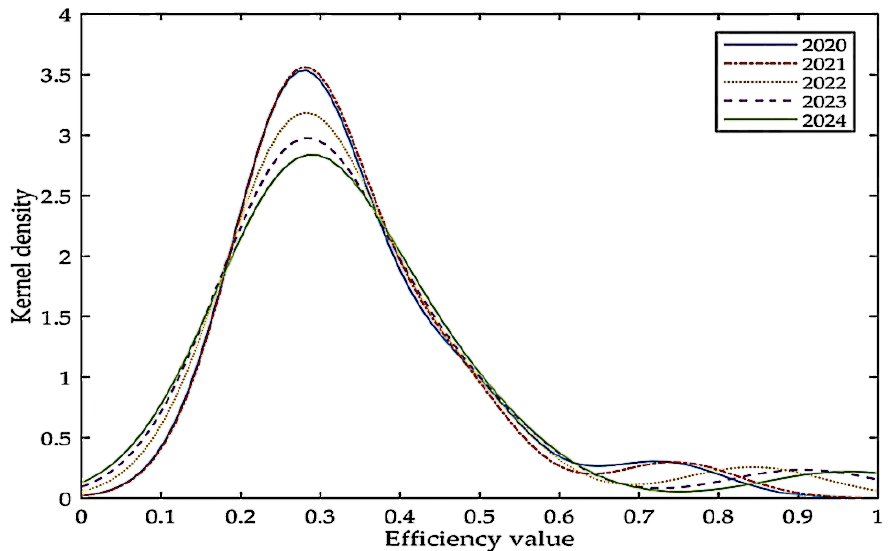
Figure 3. Kernel density estimates of low-carbon economic efficiency values in South Korea.